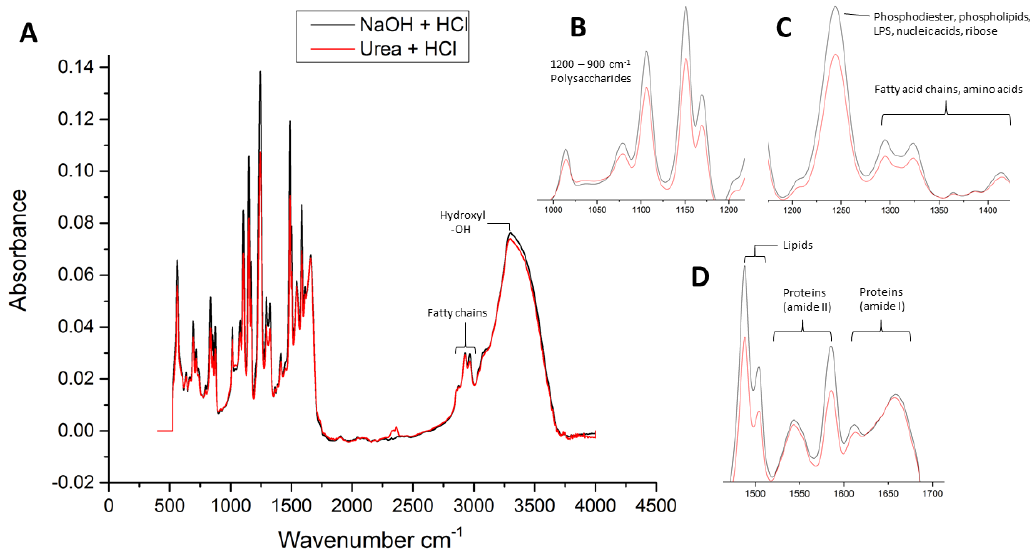
Figure 7. ( A ) Full FTIR spectra of the surface fouling layer on membrane modules cleaned with NaOH + HCl ( black ) and Urea + HCl ( red ). Zoomed in spectral regions of ( B ) polysaccharides, ( C ) phosphodiester, phospholipids, lipopolysaccharides, nucleic acids, ribose, fatty chains, amino acids, and ( D ) lipids and